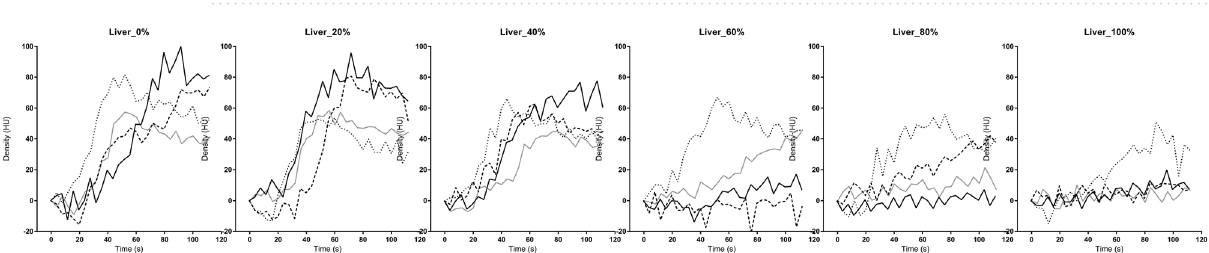
Figure 2. Time-density curve of the liver parenchyma under a regulated occlusion volume in partial resuscitative endovascular balloon occlusion of the aorta. The peak density of the time-density curve gradually decreased, and the time to peak was increasingly delayed as balloon volume